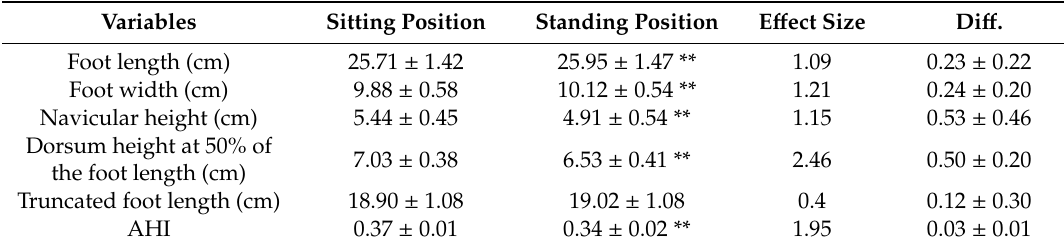
Table 2. Foot morphological characteristics of all